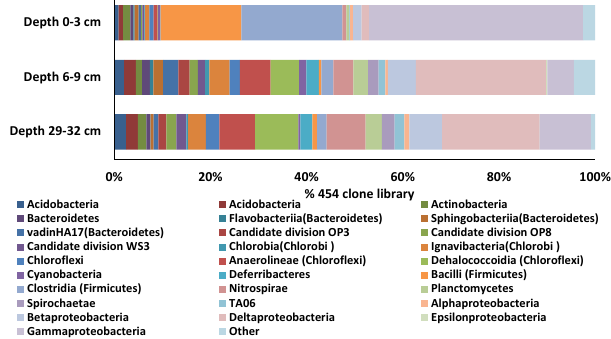
Figure 3. Classification of bacterial sequences using SILVA ngs pipeline. Phyla and class distributions of sequences of the 454 se- quencing above 1% at the different depths in the communities.